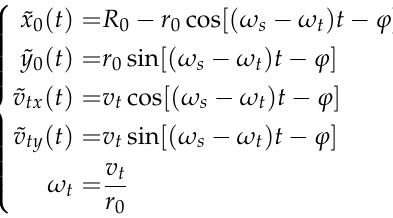
Figure 16 is the top view of the target motion at t = 0. The target locates at position A at t = 0. v t is the rotating speed, r 0 is the rotating radius, and ϕ is the angle (at t = 0)